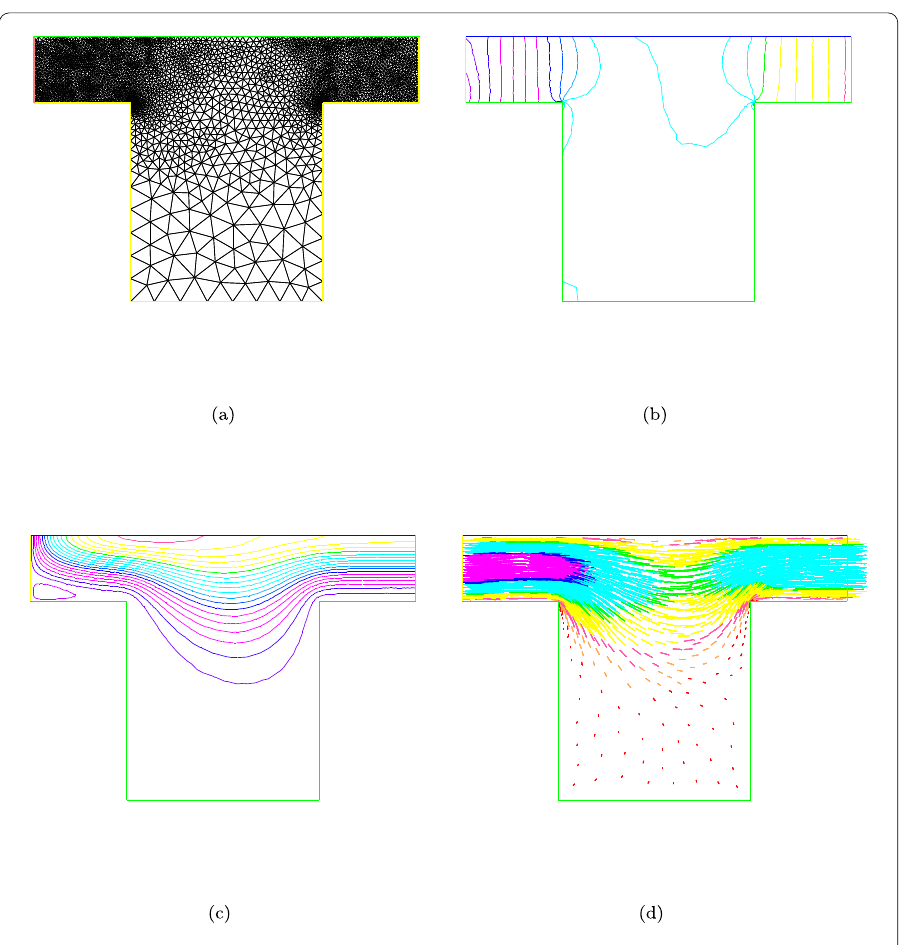
Figure 8 The mesh, the profiles of pressure and velocity, and the velocity vector with NT =